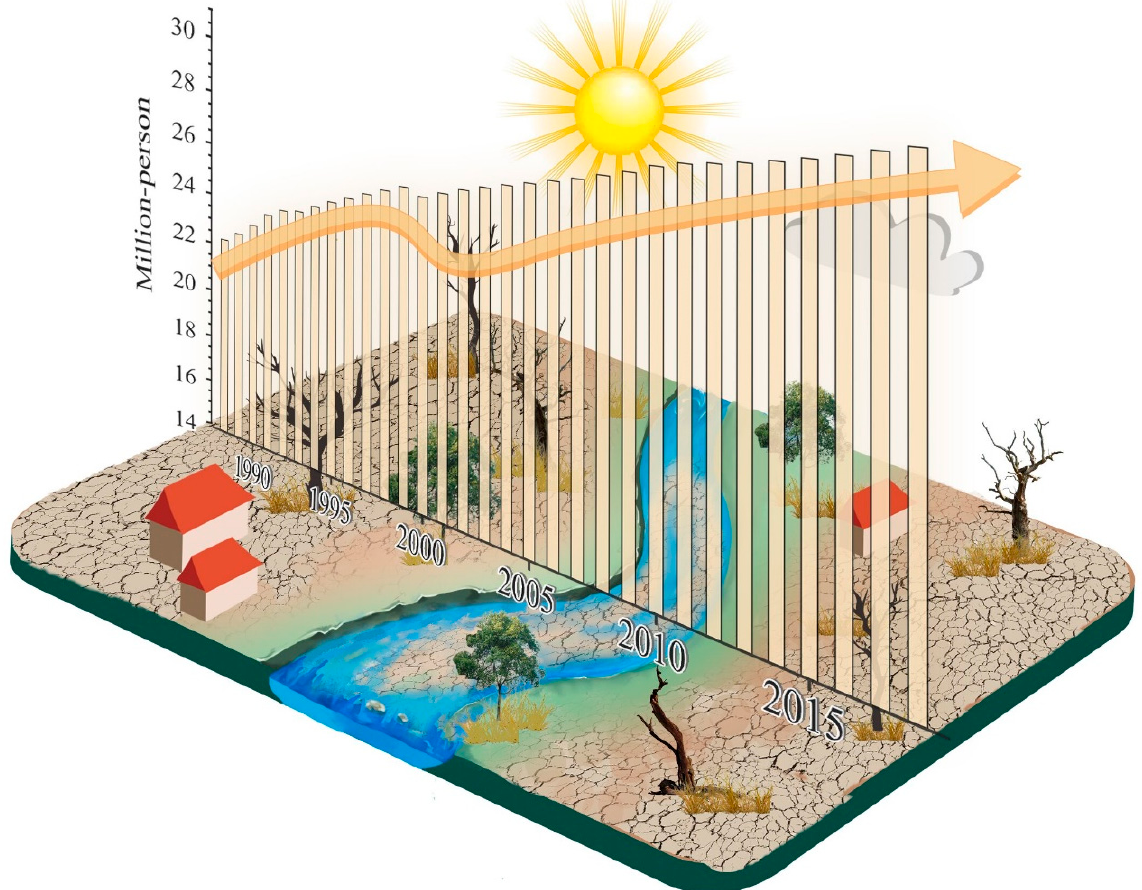
Figure 17. Schematic diagram of population exposure to compound droughts and heatwaves over the GRB.